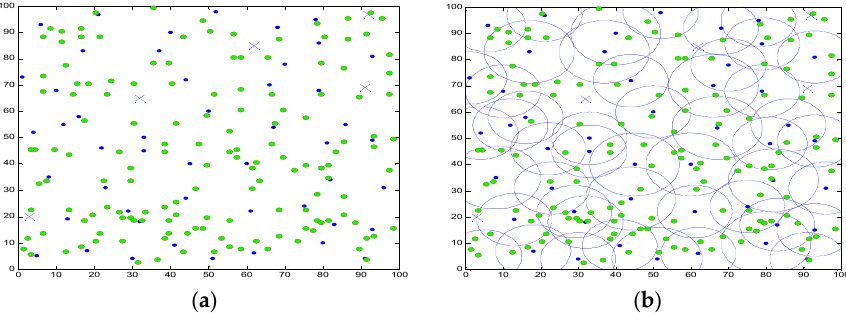
Figure 8. The distribution and coverage while some active nodes failed. ( a ) Some nodes being depleted; ( b ) Coverage hole.